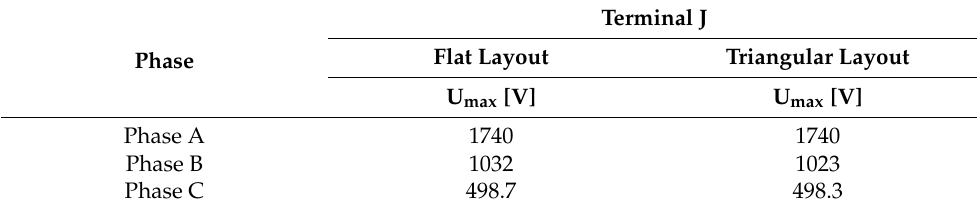
Table 4. Maximum overvoltage according to the cable system layout.